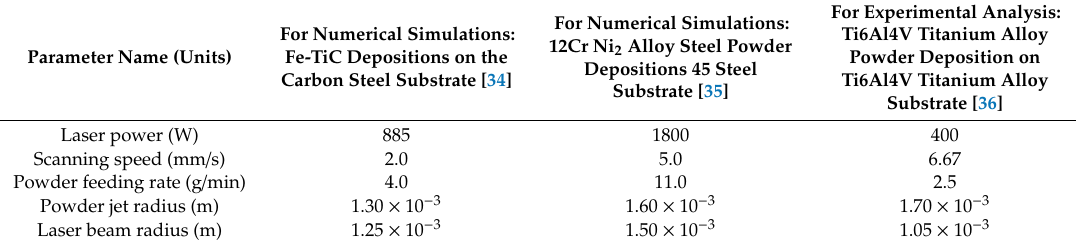
Table 2. Parameters opted for temperature distribution analytical simulations.